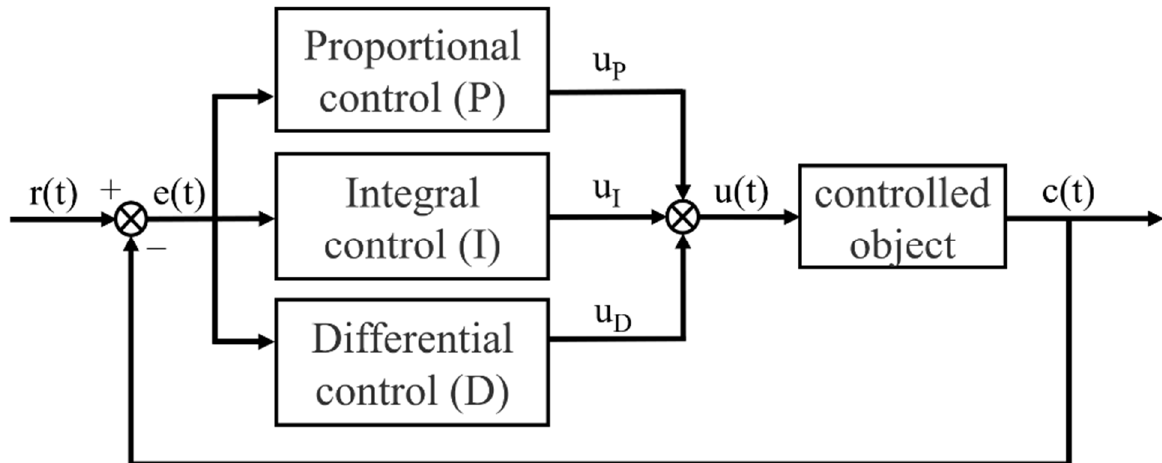
Figure 10. PI controller working